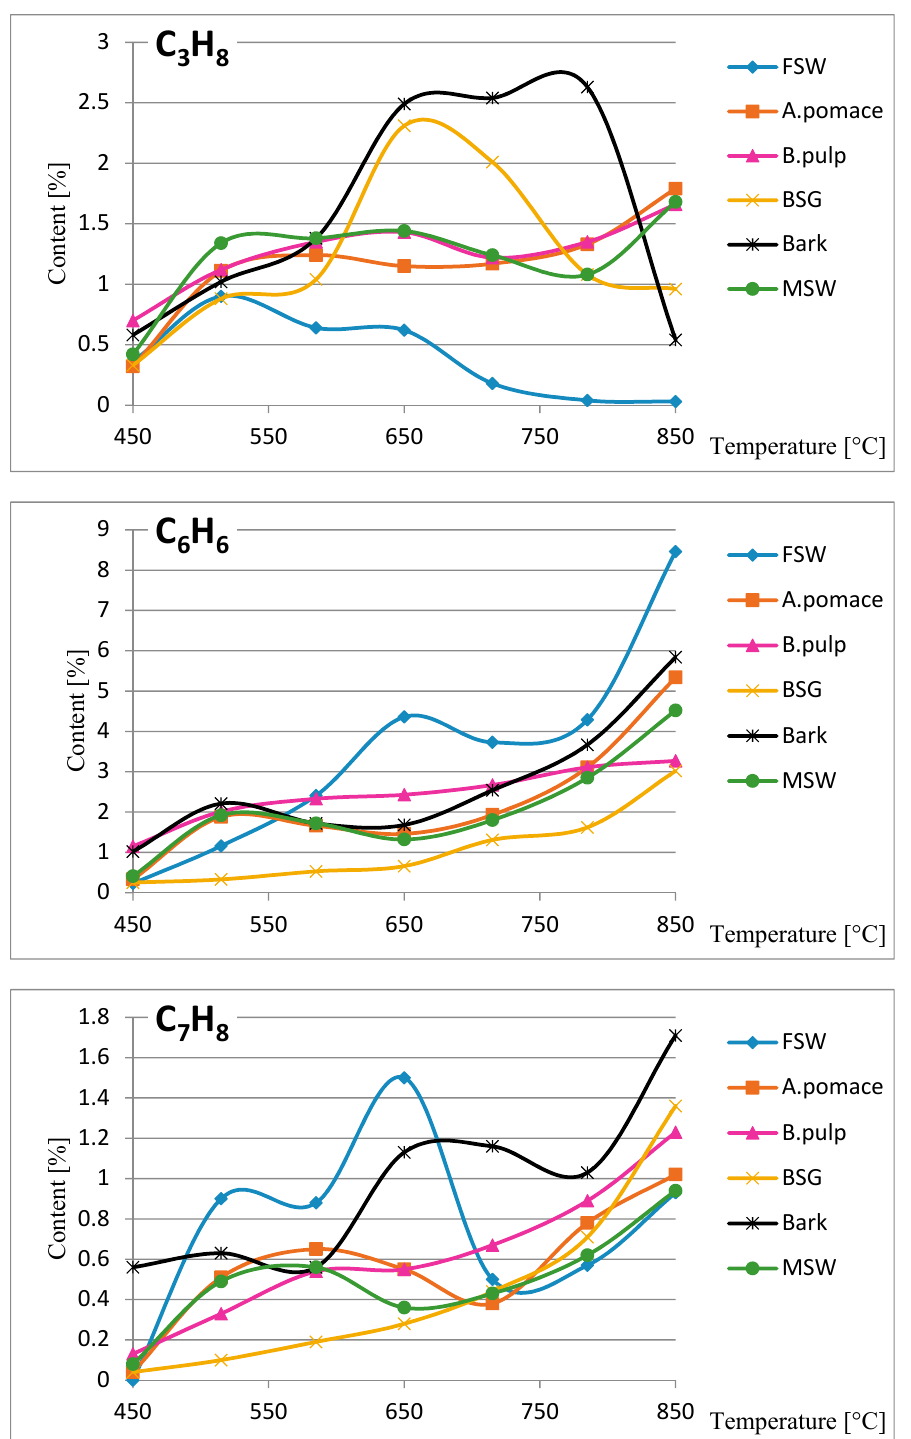
Figure 3. Volatile fractions produced during biomass pyrolysis as a function of temperature. FSW—flavored spirits production waste (lime, grapefruit and lemon), B.pulp—beetroot pulp, A.pomace— apple pomace, BSG—brewer’s spent grain, bark, MSW—municipal solid waste.